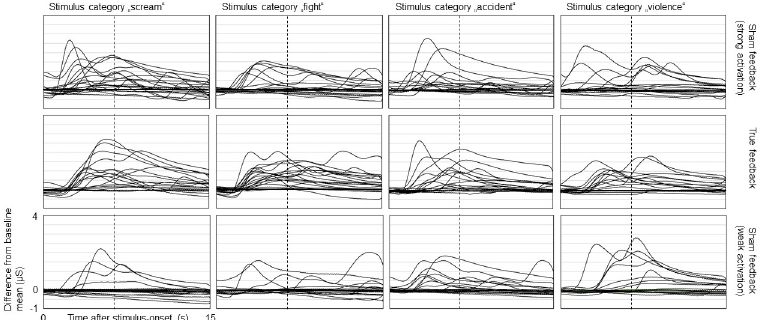
Fig 6. Individual SCR to auditory stimuli during true biofeedback and sham feedback. Individual SCR (n = 20) to auditory stimuli from four negative categories while providing true biofeedback (middle row) and sham feedback that suggest strong (upper row) and weak activation (lower row). Signal courses depict differences from baseline mean (set to zero on the y-axis). Vertical dotted lines indicate end of auditory stimulation (after 6s). For purposes of presentation, curve progressions are smoothed using a sliding average of one second (32 data